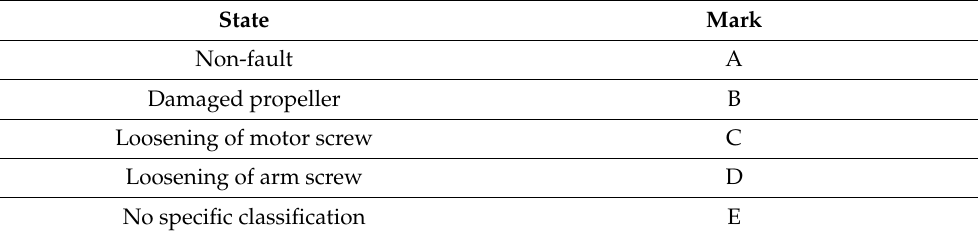
Table 11. Simple expressions used to represent states.